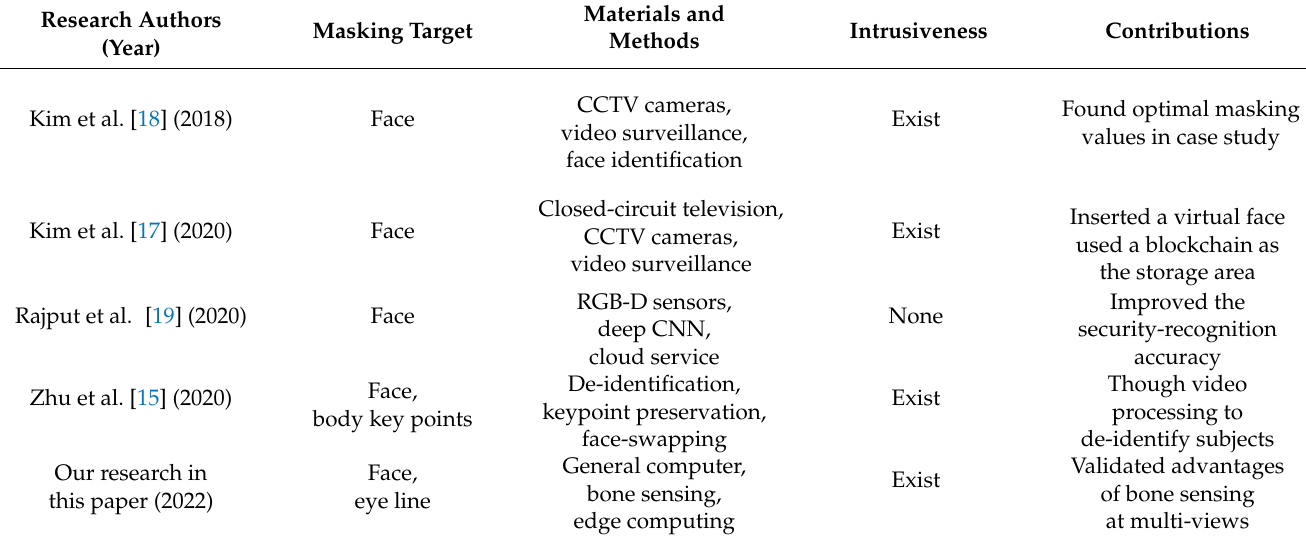
Table 1. A comparison of related work for the face